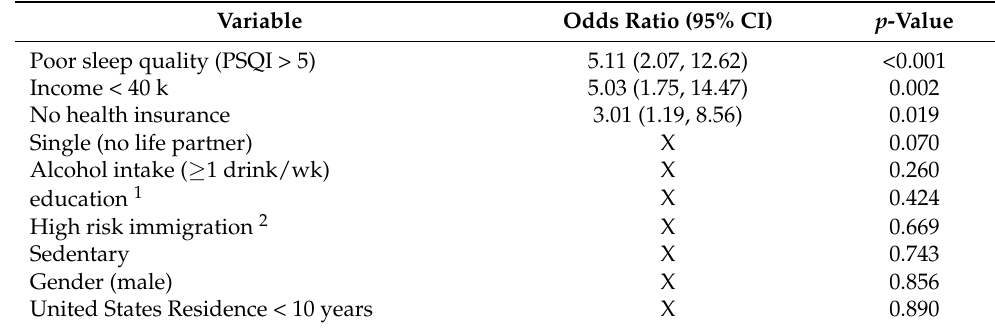
Table 3. Backward stepwise logistic regression to determine odds of being in the high-stress